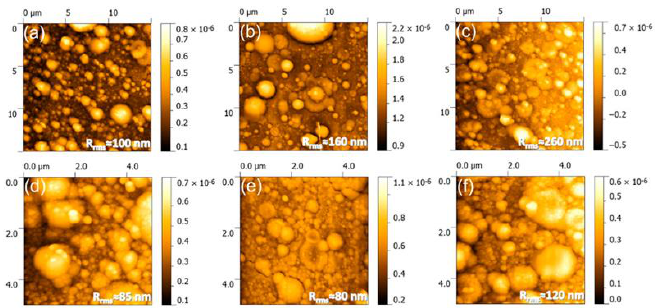
Figure 9. AFM images of rough surfaces (particles of 50–200 nm) of PLD coatings obtained from ( a , d ) commercial HA, ( b , e ) sea bream-BCP, and ( c , f ) salmon-BCP powders. The images were rec- orded on ( a – c ) 15 × 15 µm 2 and ( d – f ) 5 × 5 µm 2 areas. Reproduced with permission from [113]. Cop- on ( a – c ) 15 × 15 µ m 2 and ( d – f ) 5 × 5 µ m 2 areas. Reproduced with permission from [113]. Copyright yright MDPI, 2020. MDPI, 2020.